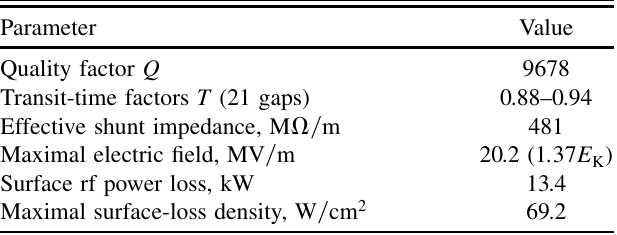
TABLE V. EM Parameters of IH1 tank.